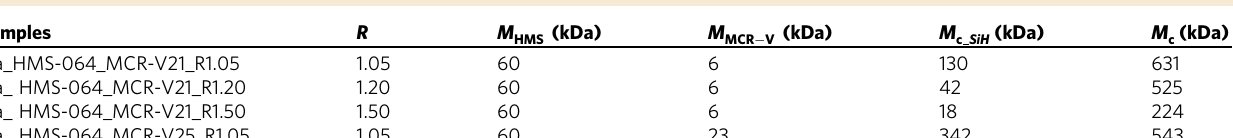
Fig. 4 Properties of highly stretchable silicone elastomers and a conventional silicone elastomer. a Uniaxial stress – strain curves. b Frequency dependence of storage and loss moduli ( G ´ and G ´´) measured at room temperature. c Biaxial stretching. (c-1) The highly stretchable silicone elastomer is marked with a red 1 cm 2 square; (c-2) the area of the same fi lm is manually extended 180-fold. (c-3) The extended fi lm subsequently covers the surface of a football with a diameter of 21 cm. (c-4) The conventional silicone elastomer marked with a 1 cm 2 red square is extended to a maximum of 9 times its original area. Table 3 Speci fi cations for studied soft silicone elastomers.